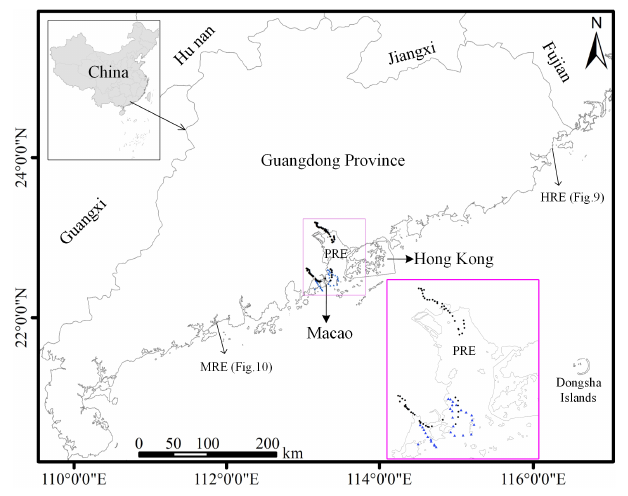
Figure 1. Study areas (PRE, HRE, and MRE) and the locations of the in situ data indicated by black dots and blue triangles.